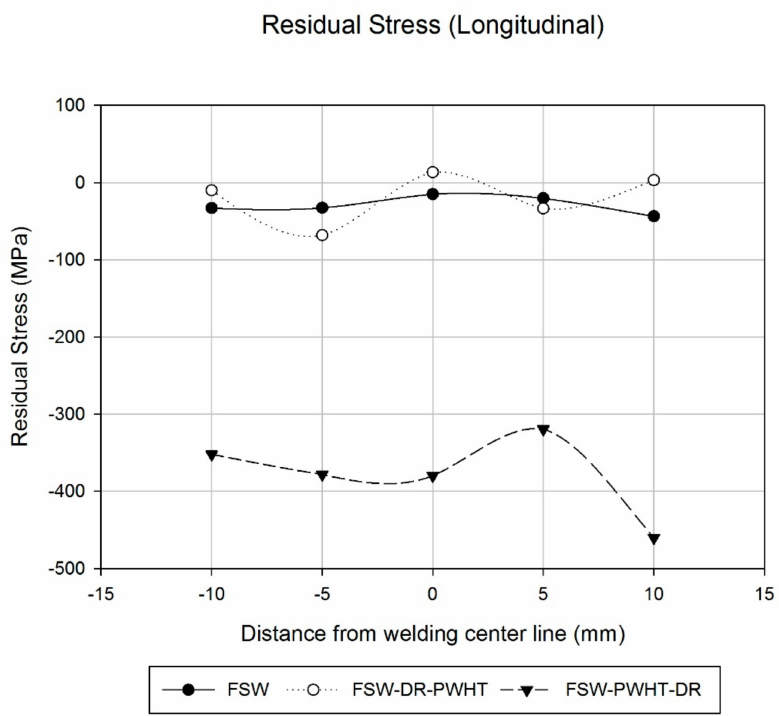
Figure 11. Residual stress in longitudinal